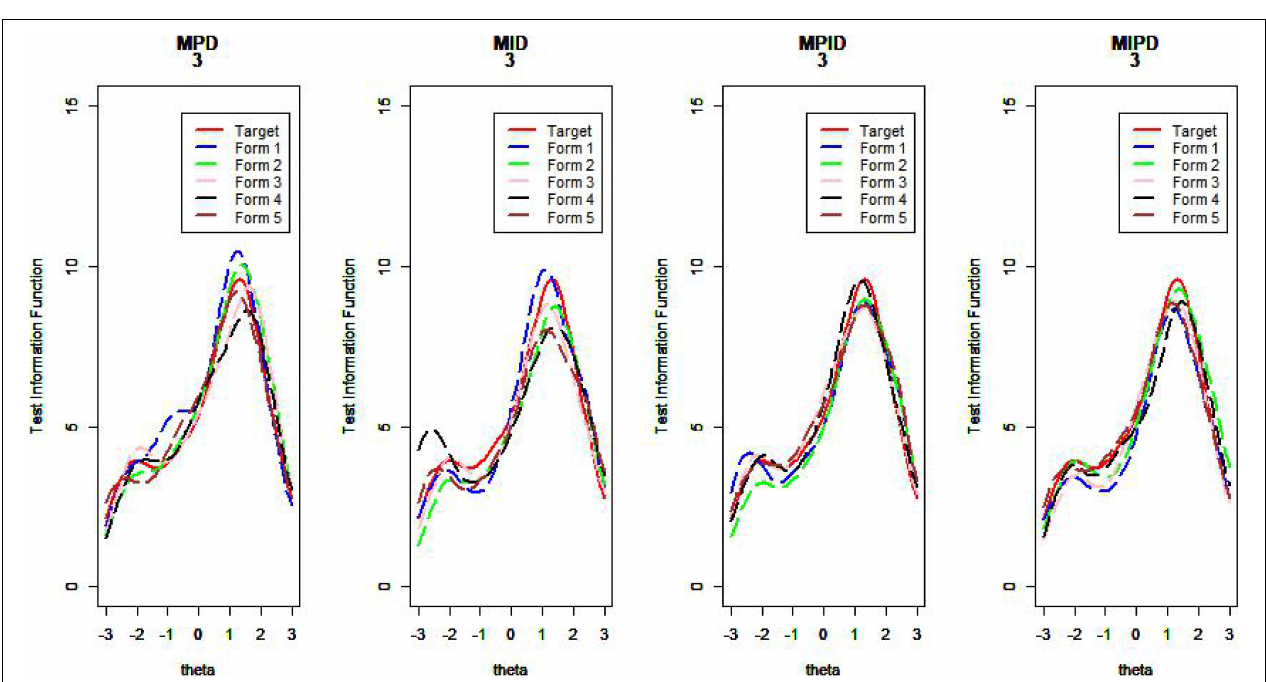
FIGURE 13 | Test information curve ( D =